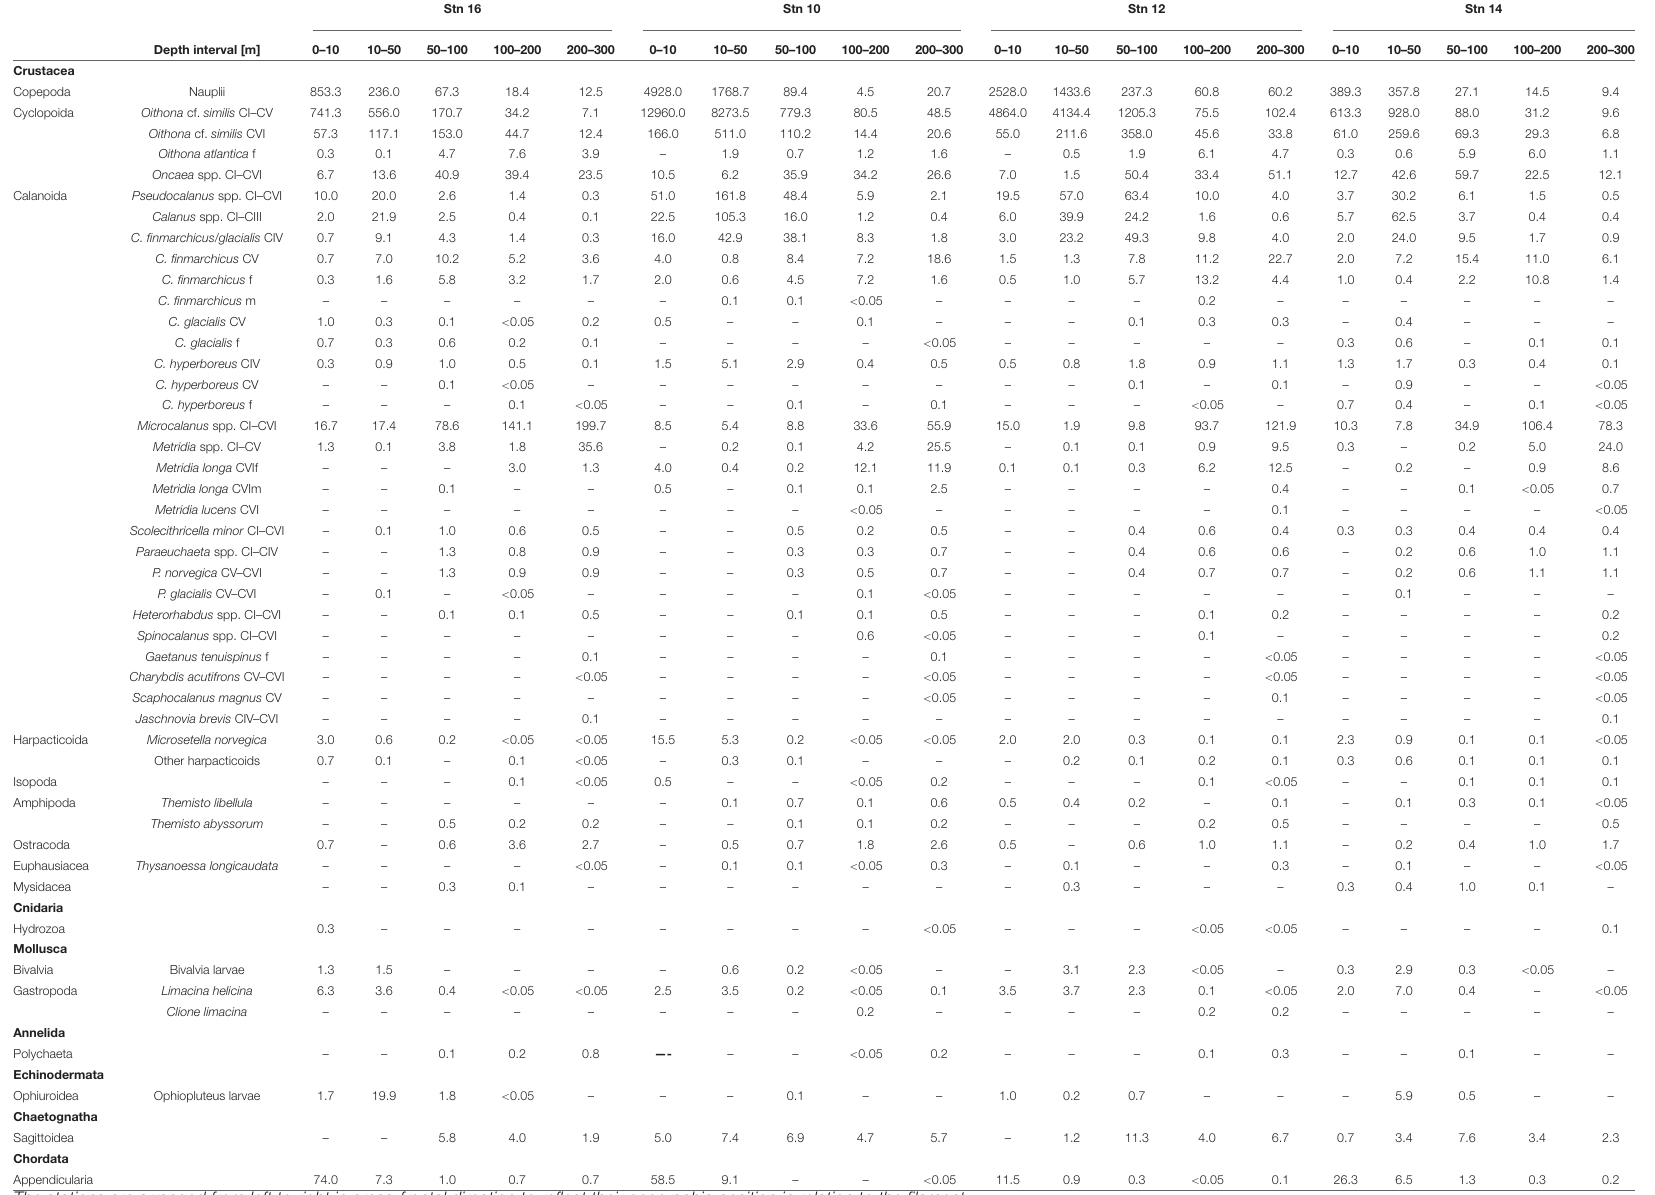
The stations are arranged from left to right in cross-frontal direction to reflect their geographic position in relation to the